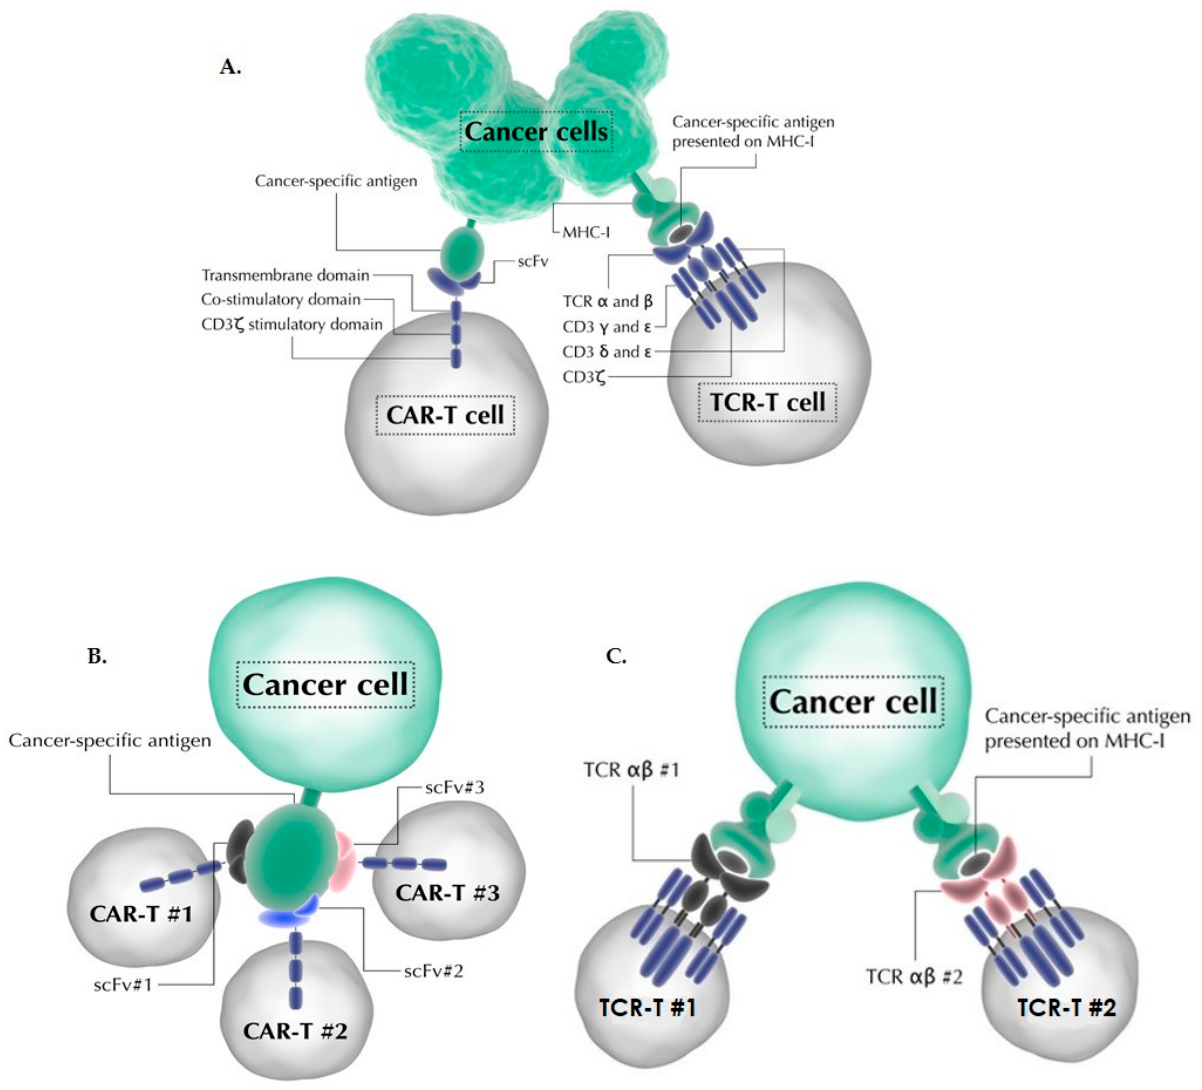
Figure 1. Schematics of common CAR-T and TCR-T cellular immunotherapy products. ( A ) Components of common chimeric antigen receptor (CAR) and T-cell receptor (TCR) used in clinical trials. CAR-T cells express a chimeric receptor on their surface composed of a single-chain fragment variable (scFv) domain, a transmembrane domain, and co-stimulatory and stimulatory domains. The scFv domain binds to cancer-associated antigens on the surface of cancer cells. The transmembrane domain positions the receptor on the cell surface, while co-stimulatory (usually CD28 or 4-1BB fragments) and stimulatory (CD3 ζ fragment) domains activate the T cell, resulting in cytotoxicity and proliferation. Cancer-associated antigens targeted by CAR-T cells are typically differentiation antigens or other antigens that are over-expressed by tumor cells. TCR-T cells are characterized by the presence of a TCR composed of α and β chains. TCR binds specifically to a small peptide presented by major histocompatibility complex-I (MHC-I), and upon binding TCR activates the T cell via endogenous CD3 signaling. Most commonly, TCR-Ts target cancer/testis antigens (CTAs)-antigens that are expressed only by cancer cells, germ cells, and placental tissue. These antigens are expressed inside the cell and require MHC-I